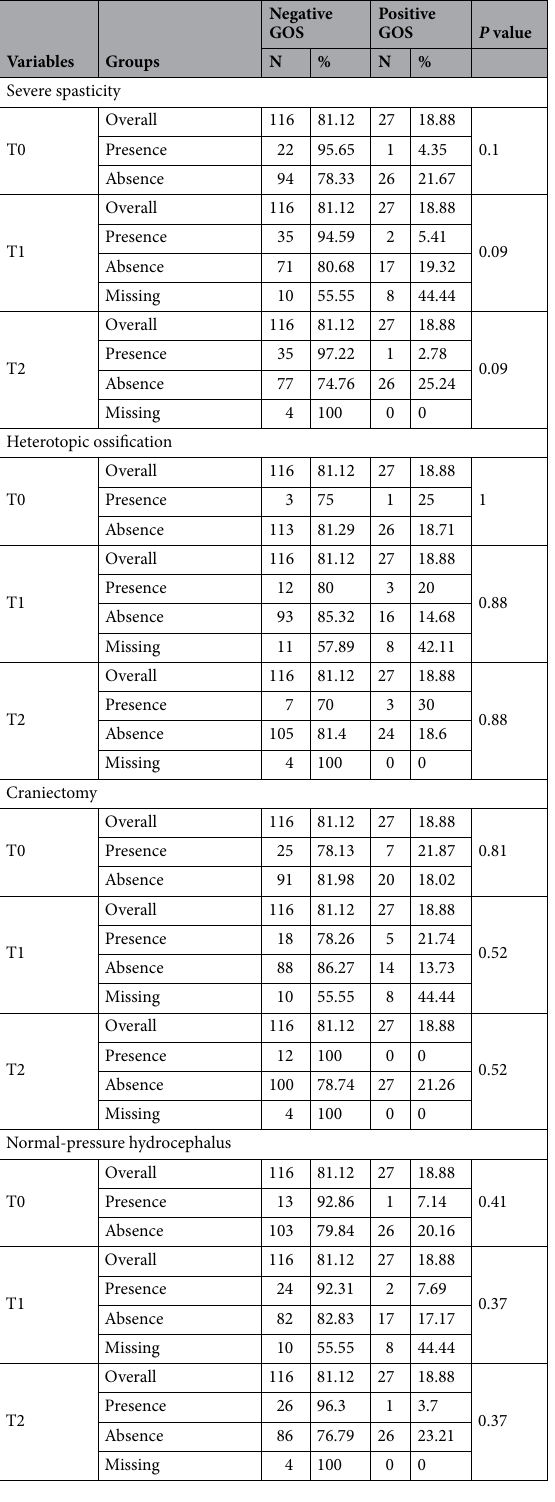
Table 2. Absolute frequencies and percentages of categorical demographic and clinical predictors at baseline (T0), after 4 months from the event (T1) and at discharge (T2) according to the GOS binary categorization (positive/negative). TBI traumatic brain injury, MCS minimally conscious state, VS/UWS vegetative state/ unresponsive wakefulness syndrome, PEG percutaneous endoscopic gastrostomy, NG tube nasogastric tube, PSH paroxysmal sympathetic